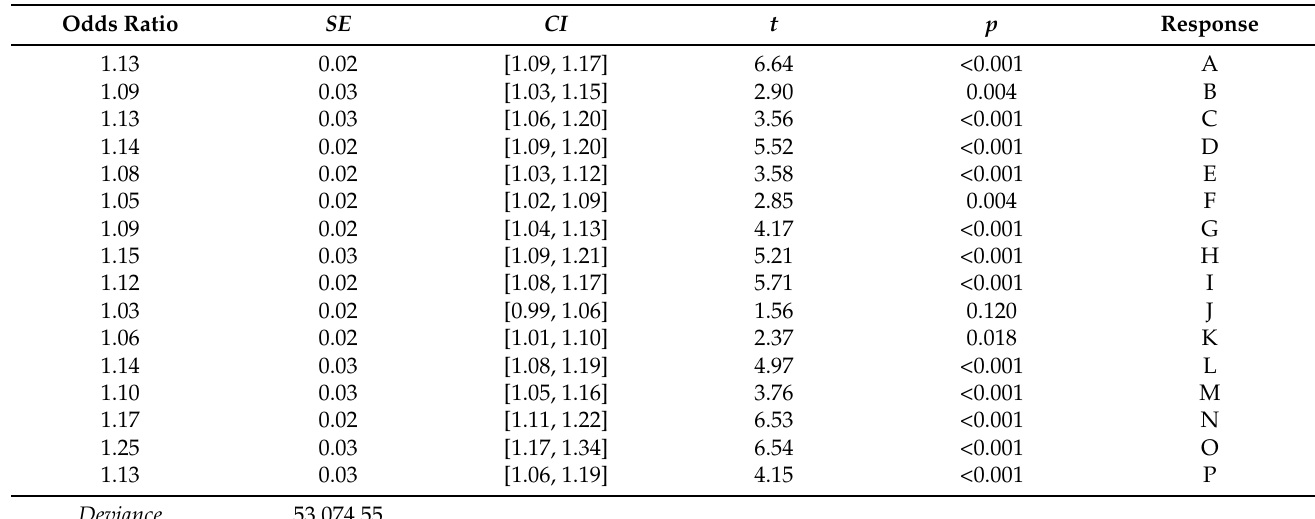
Table A14. Emospace widget response multinomial logistic regression model for extroversion concerning the space of a widget as clusters.